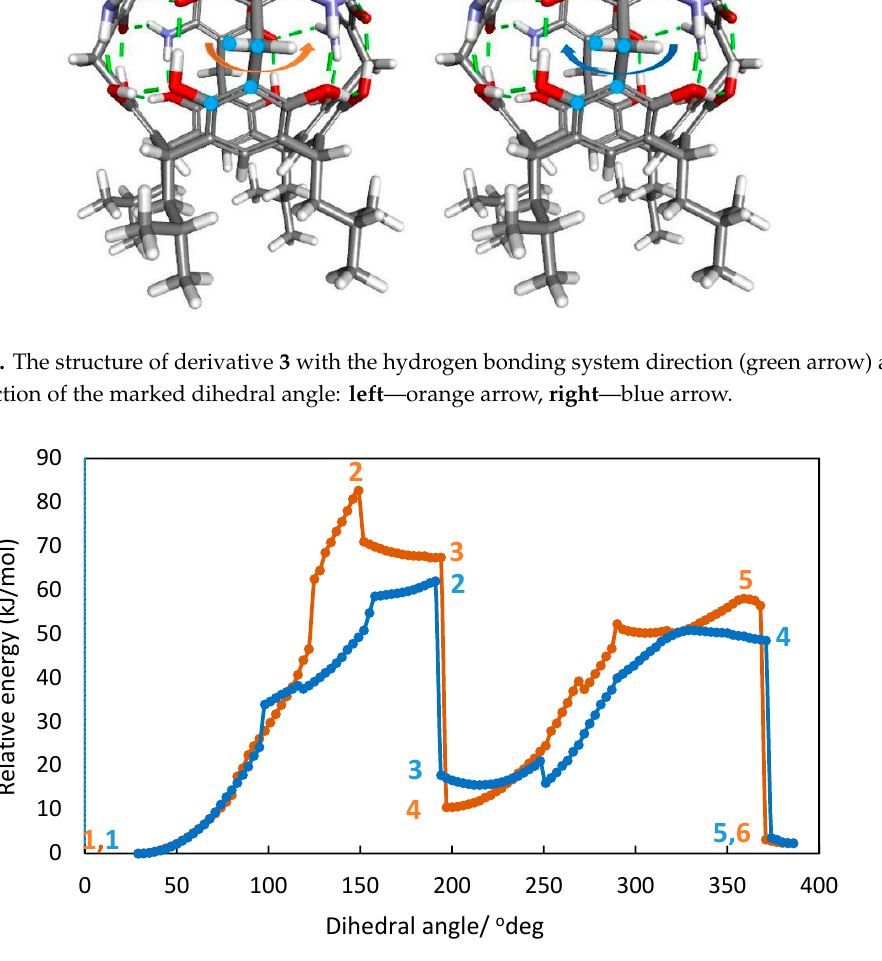
Figure 7. The changes in the relative energy of derivative 3 with respect to the dihedral angle (blue curve—angle changes from the left, orange curve—from the right). The calculations were performed using the GFN2-xTB semiempirical DFT in CHCl 3.